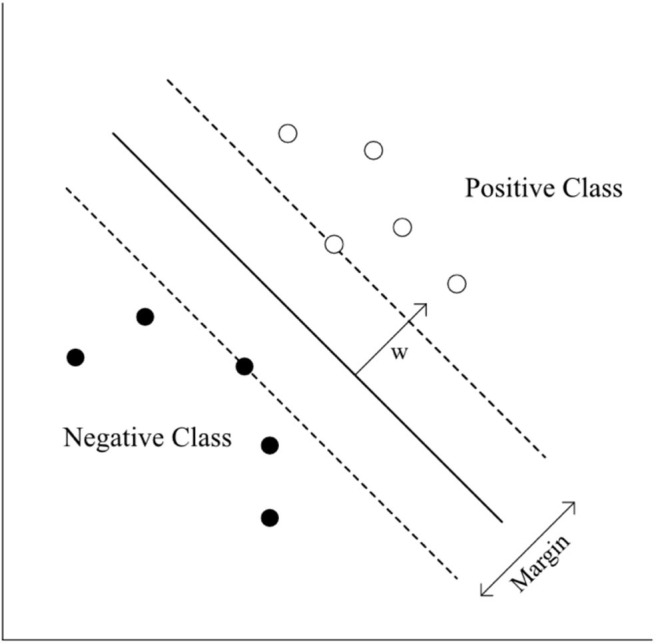
SVM classification.